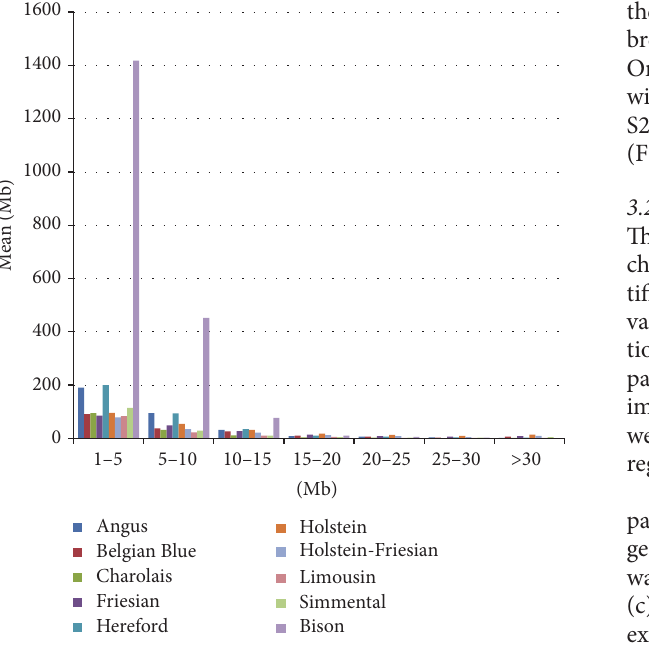
Figure 1: The mean sum of runs of homozygosity (ROH) per genotyped individual, measured in Megabases (Mb) within each population, for each considered ROH length